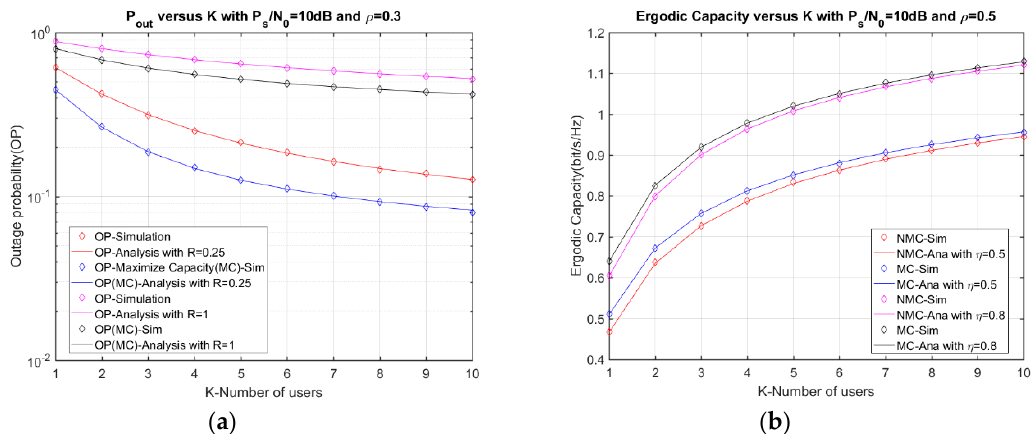
Figure 7. The outage probability ( a ) and ergodic capacity ( b ) versus the numbers of users.